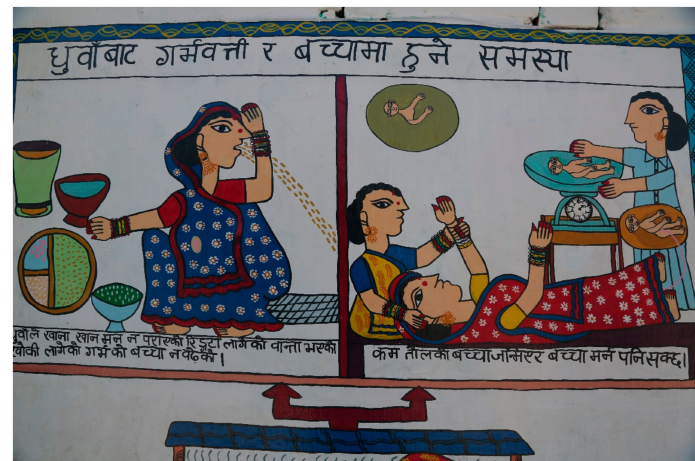
Figure 3. The effects of air pollution on women and newborn children. Translation: Top heading = Problems due to smoke in the mother and infant. Left photo = “Smoke causing poor appetite, giddiness, cough, and vomiting. Baby in utero not increasing in size”. The picture describes some of the health consequences for a pregnant woman, and the adverse effect on the growth of her fetus. Right photo = “Low birthweight baby may be born and may die as well”. This picture shows the result of air pollution exposure to the pregnant woman. It can lead to death of the fetus or newborn, or impair growth, leading to low